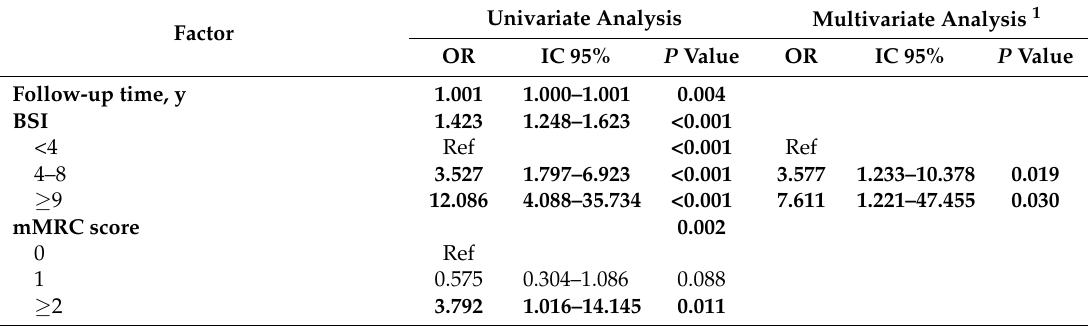
Table 4. Logistic regression analysis of CBI predictive